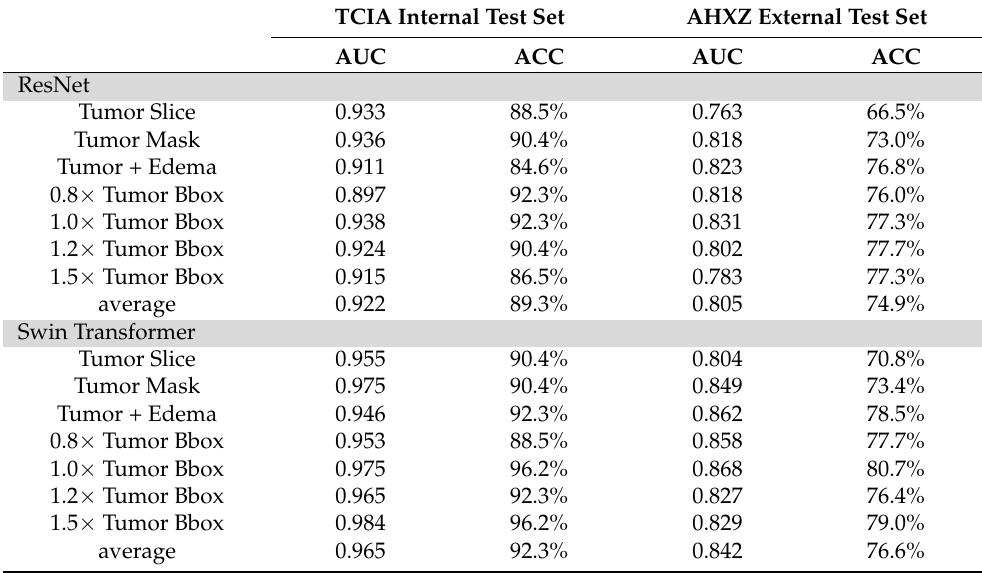
Table 3. Patient-level diagnostic performance of the models for the IDH mutation status prediction. TCIA Internal Test Set AHXZ External Test Set AUC ACC AUC ACC